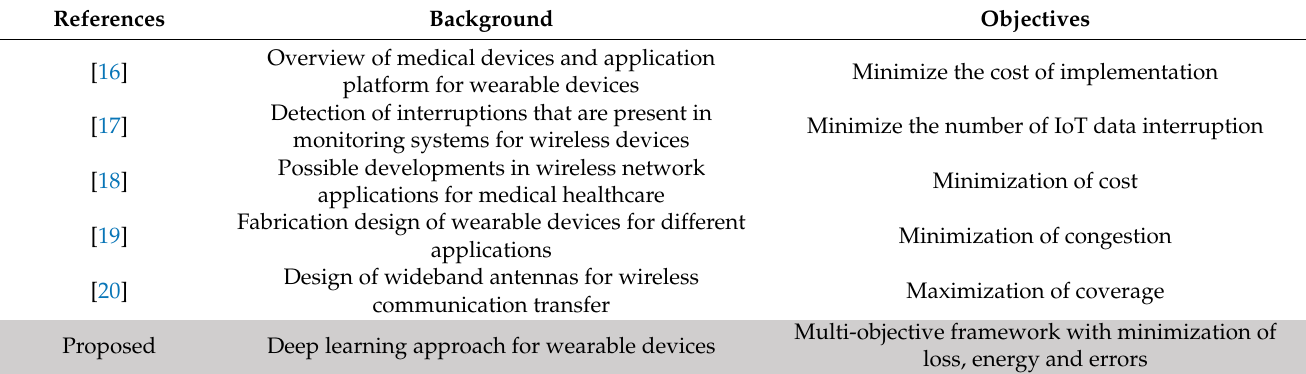
Table 1. Background and objectives (existing vs.